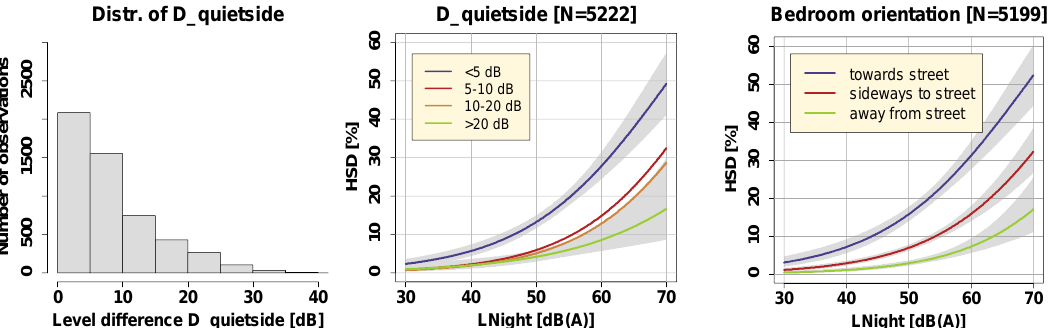
Figure 6. Left: Frequency distribution of the level difference indicator D_quietside. Middle: Exposure-response relationships for road traffic noise for four groups of D_quietside; 95% confidence intervals as shaded areas shown for the <5 dB and >20 dB category only. Right: Exposure-response relationships for road traffic noise for different orientations of the bedroom window, including 95% confidence intervals as shaded areas. LNight always refers to the maximum façade point of the dwelling unit. Curves are based on the adjusted model in the full sample with covariates centered on the mean.